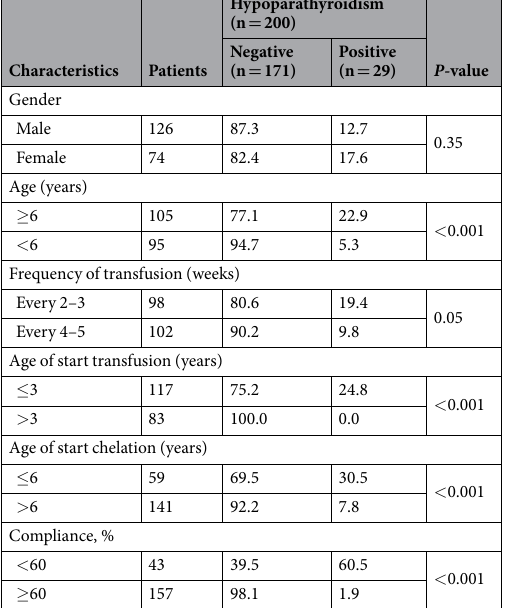
Table 7. Association between hypoparathyroidism and each of the demographic, frequency of transfusion, age of start transfusion, Age of start chelation, compliance.